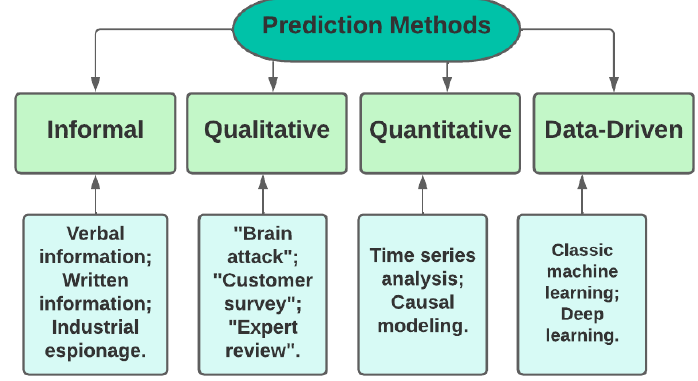
Figure 4. Types of traditional prediction